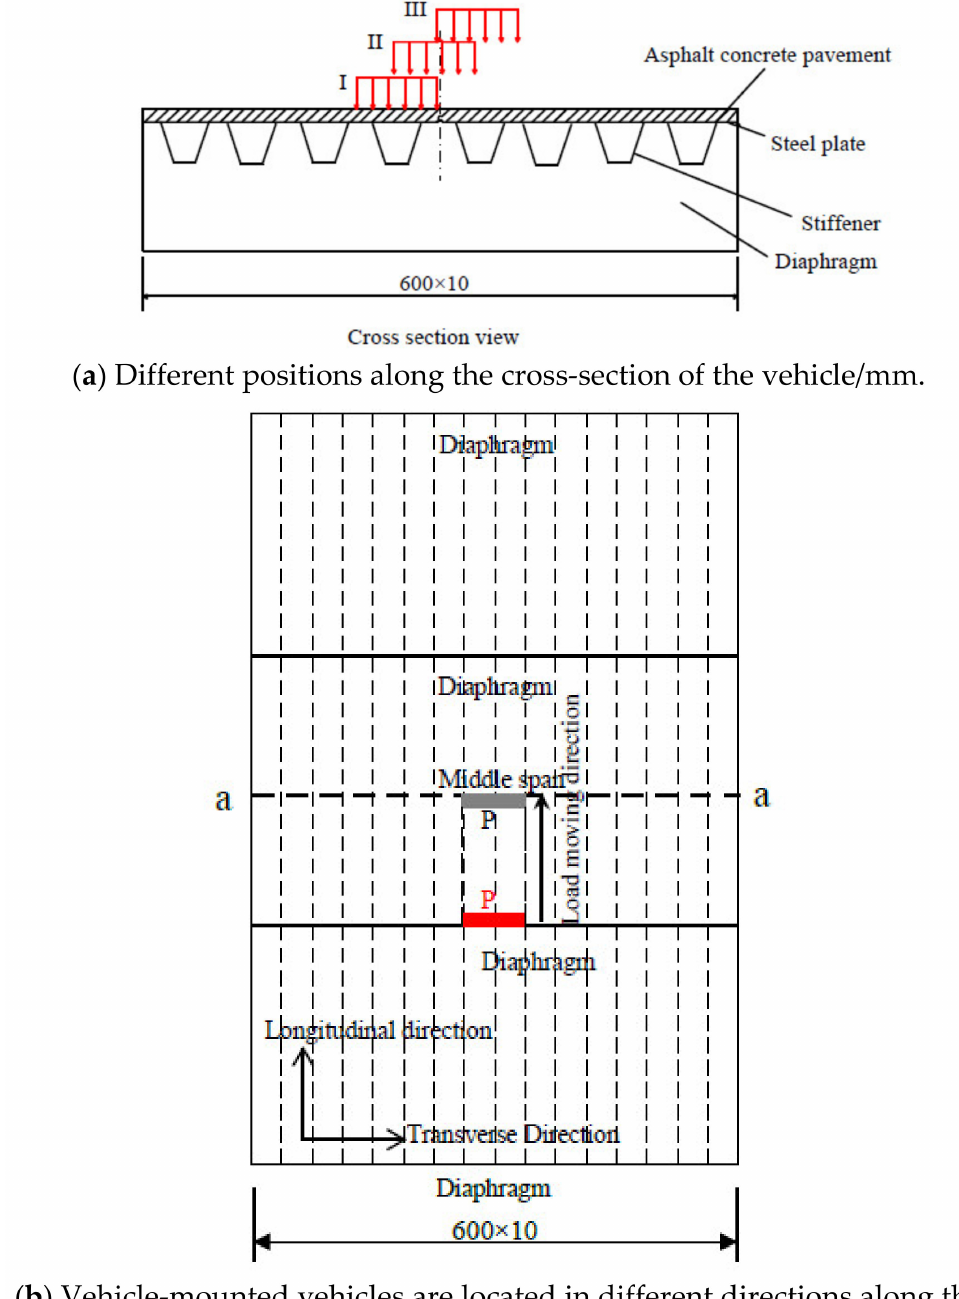
Figure 4. Calculation model and load action of orthotropic steel bridge deck pavement system. The deck pavement of the Sutong Yangzi River Bridge is a laminate structure. Ac- cording to the symmetry of the box girder, eight longitudinal rib models can be discretized using plate and shell elements. Moreover, to maintain consistency with the actual structure of the bridge deck pavement as a simplification principle, all structures that contribute to the overall stiffness and local strength of the pavement structure are considered. The shell element was established at the physical location of the middle surface of the thin plate, and the mesh was refined at the focal points. The finite element model that was used is shown in Figure